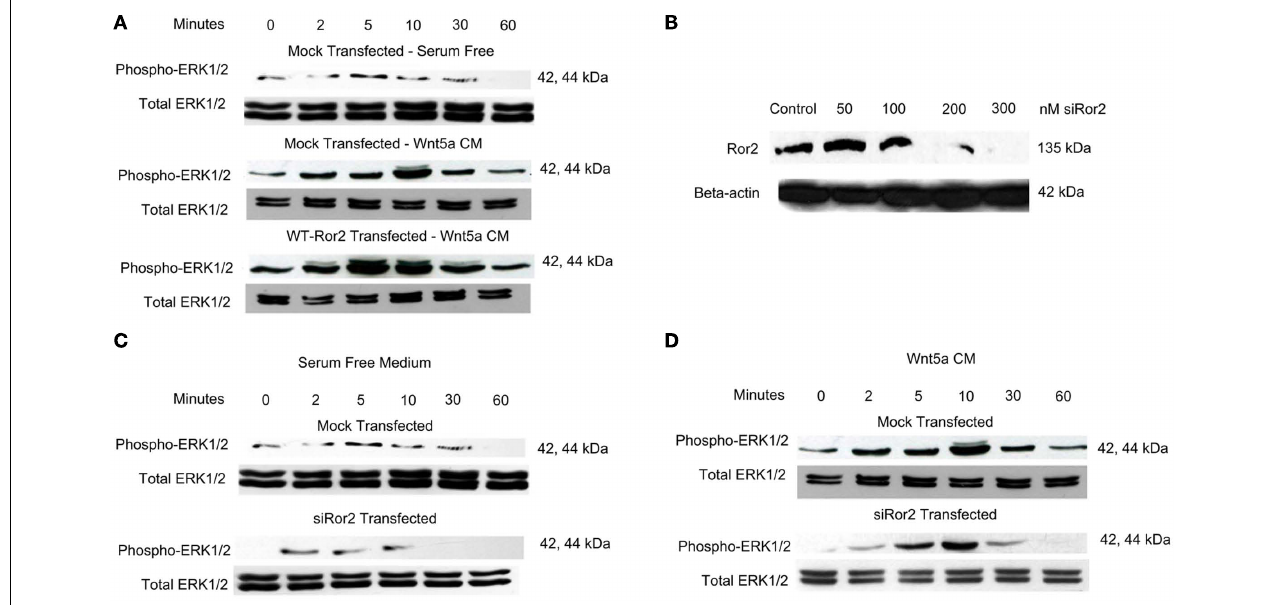
FIGURE 2 |Wnt5a stimulation of Ror2 induced ERK 1/2 (p44 and p42) phosphorylation in HT29 cells. (A) HT29 cells were grown in DMEM supplemented with 10% FBS, transfected withWT Ror2 or no plasmid. Cells were serum starved for 18h. Cells were challenged withWnt5a CM for 0, 2, 5, 10, 30, 60min.Western blot analysis screening for total (phosphorylated and unphosphorylated) ERK1/2 expression was included as loading control.